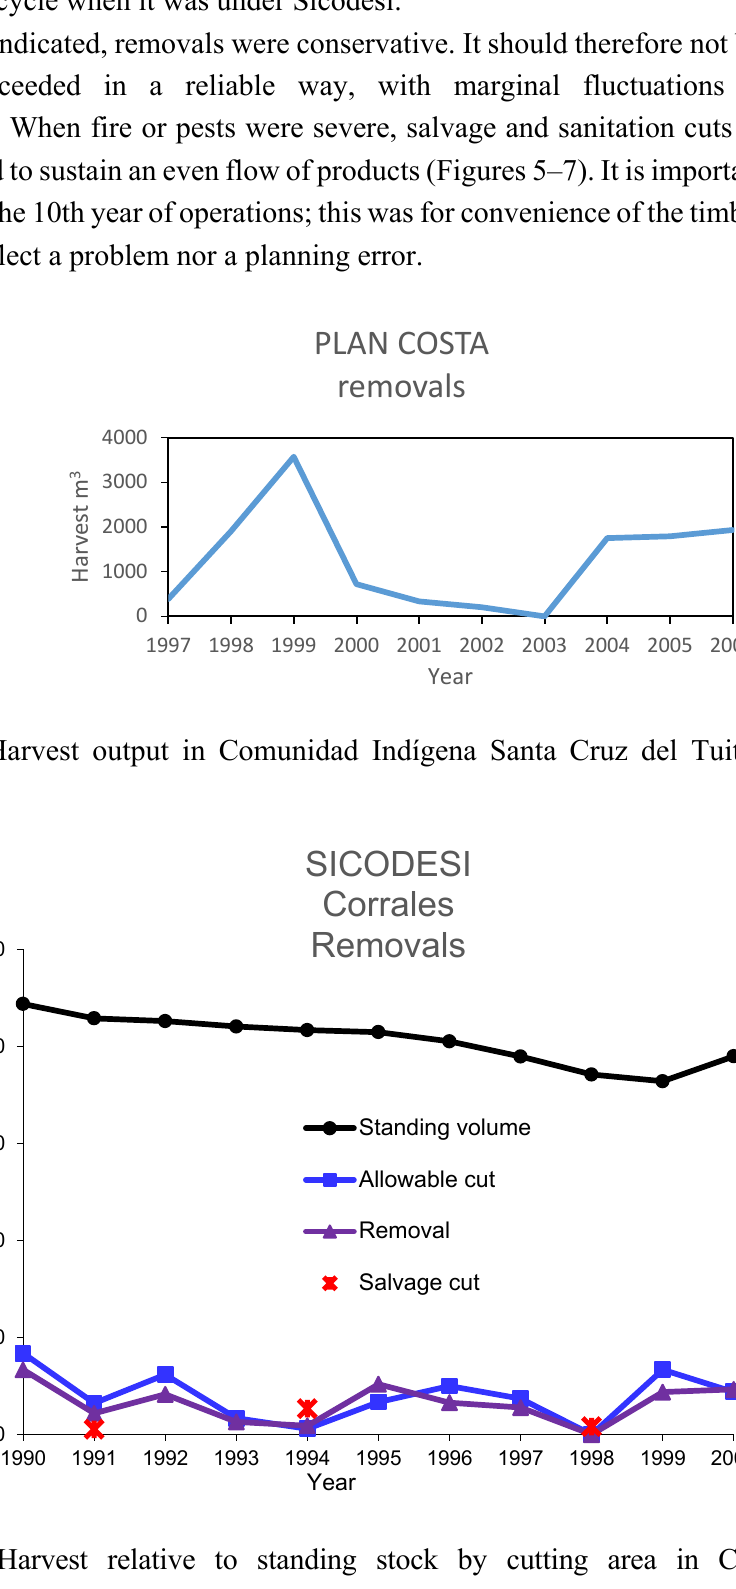
Figure 6. Harvest relative to standing stock by cutting area in Corrales, managed under